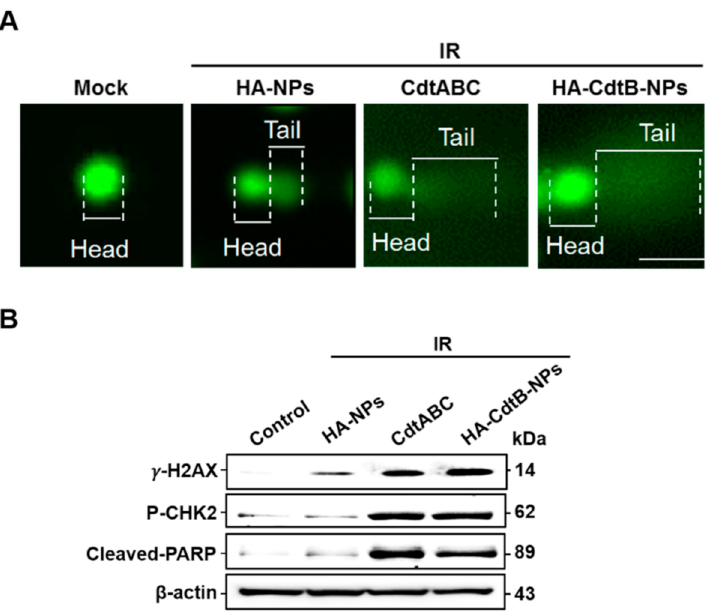
Figure 4. HA-CdtB-NPs enhance IR-induced DSB in PCa cells. PC3-KD cells were mock-treated or exposed to IR (2 Gy) followed by incubation with 100 HA-NPs, CDT holotoxin, and HA-CdtB-NPs. ( A ) Visualization of the comet tail showed IR-induced DSB in PC3-KD cells after 24 h incubation. Scale, 10 µ m. ( B ) Western blot analysis for DNA damage-related proteins, γ -H2AX, p-CHK2, and cleaved PARP after 48 h incubation. β -actin was used as a loading control.